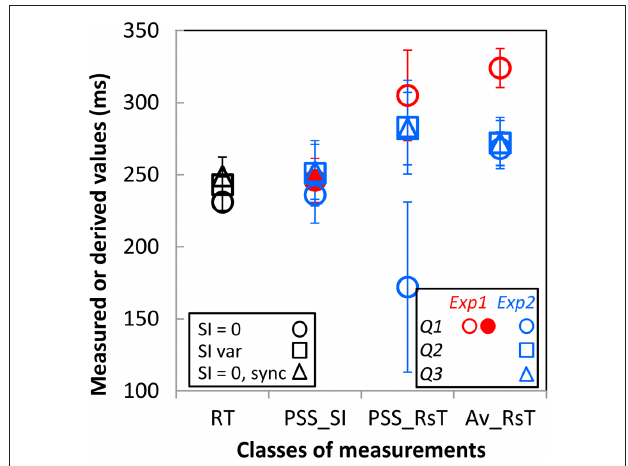
Figure 4 | reaction times (rT; black symbols), points of subjective synchronization derived from the cumulative gaussian fits of the “Yes” responses as a function of the Si (PSS_Si) and as a function of subjects’ synchronization response time (PSS_rsT) and the means of these rsT (Av_rsT) as measured or derived from the different experiments. RTs measured in response to the instantaneously filled (SI = 0) gage and to a gage filling over 0 to 500 ms intervals are shown as the black circle and square, respectively. RT derived from the fastest RsT distribution to the instantaneously filled gage in the synchronization Experiment 1 is shown a the black triangle. PSS and Av_RsT derived from responses to questions 1, 2, and 3 are shown as circles, squares, and triangles with their colors referring to the Experiment where they have been assessed (red, Experiment 1; blue, Experiment 2). The solid red circle is the PSS from Experiment 1 used as the SI midpoint of the SI range tested in Experiment 2. Each symbol is the average over the five participants with the vertical bars